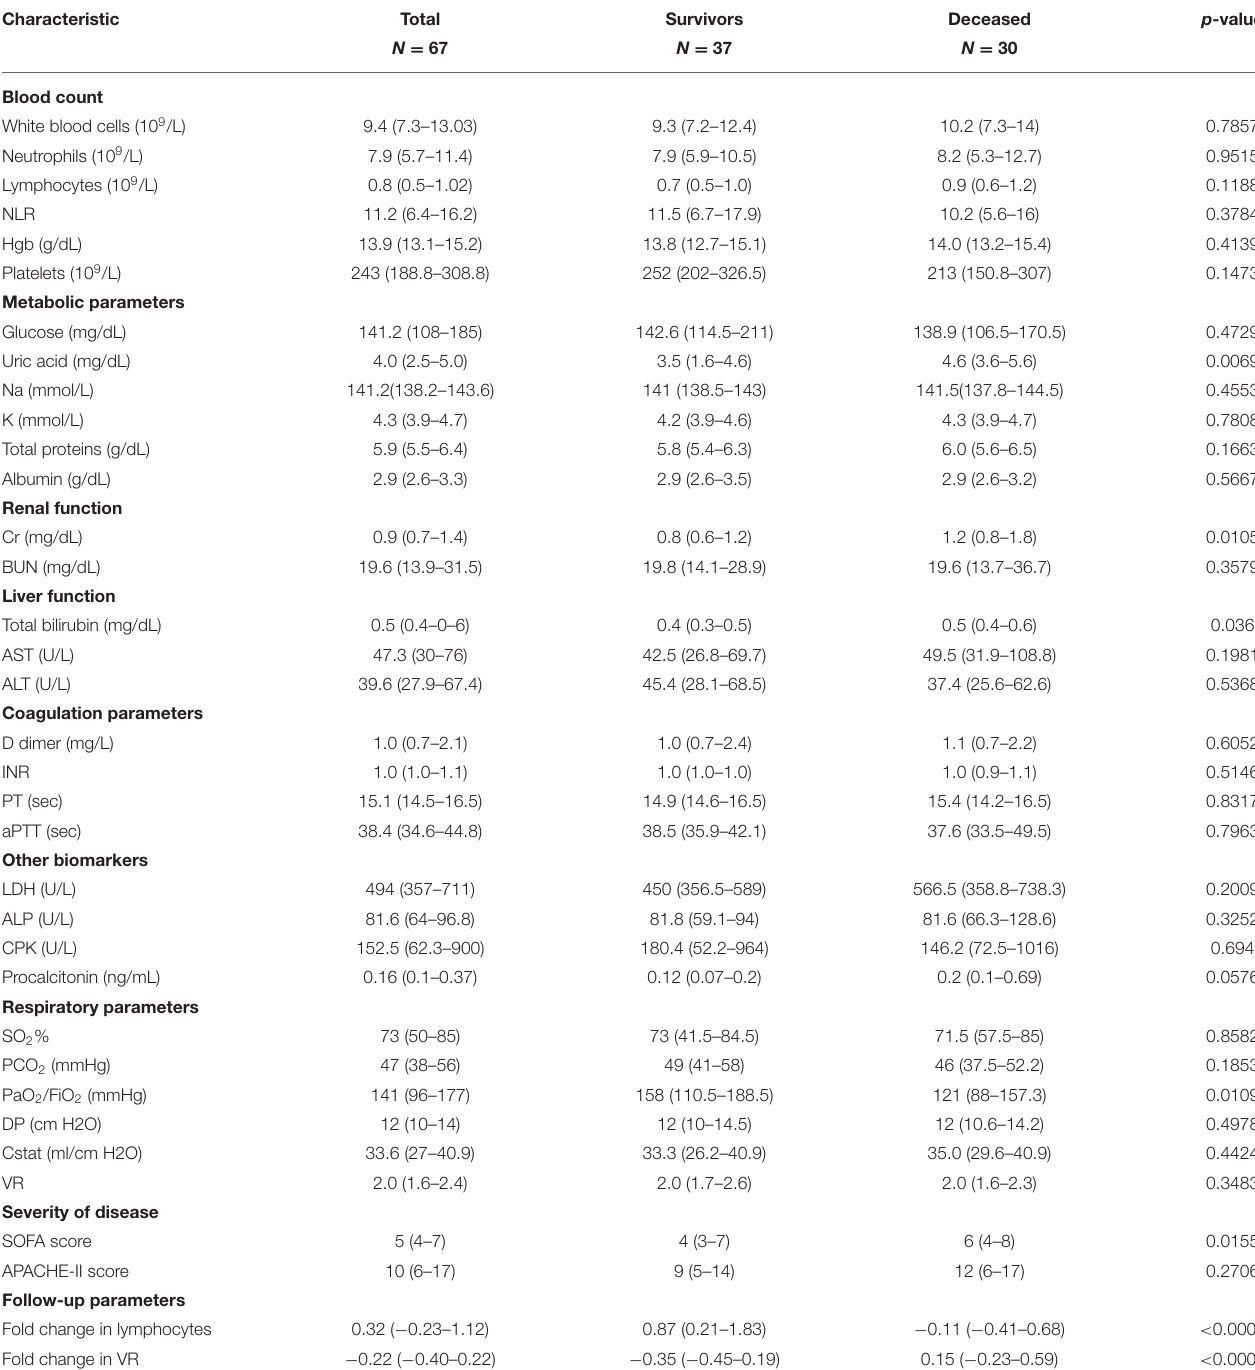
TABLE 3 | Laboratory parameters of critically ill COVID-19